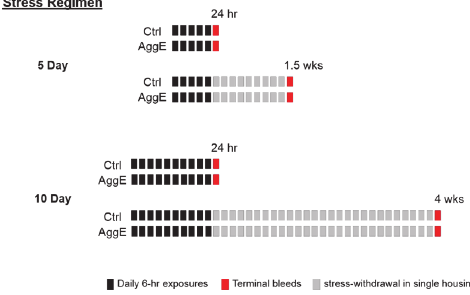
Figure 1. Study design. Mice were exposed to a trained aggressor mouse for 6 hrs daily for 5 or 10 days (black rectangles). Control mice were exposed on the same schedule and under the same conditions but with no aggressor mouse present. Terminal bleeds and tissue samples (red rectangles) were obtained 24 h after the 5- and 10-day regimens as well as 1.5 weeks after the 5-day and 4 weeks after the 10-day stressor regimens. Mice were singly housed throughout the